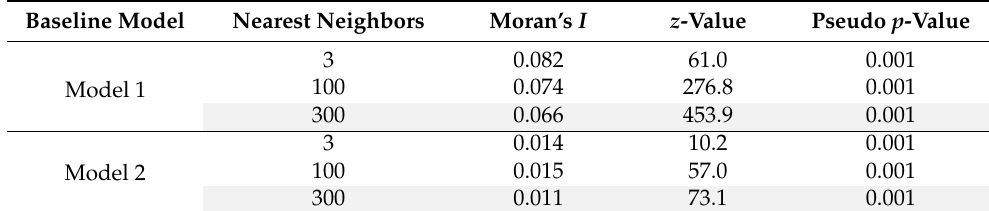
Table 3. Results of Moran’s I test on the baseline model